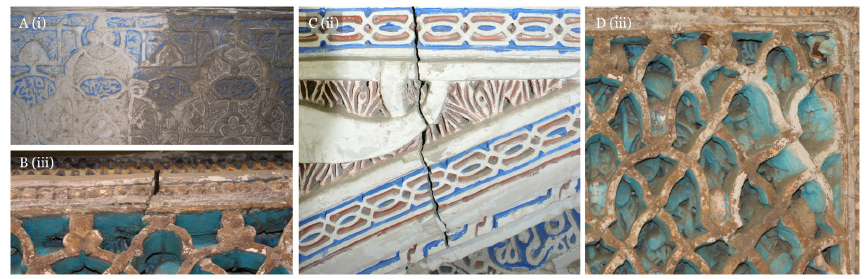
Figure 7. Some of the anomalies considered in the cases of study: ( A ) stains, ( B ) nails, ( C ) cracks, and ( D ) biodeterioration and dirt. Table 8. Classification and quantification of anomalies.